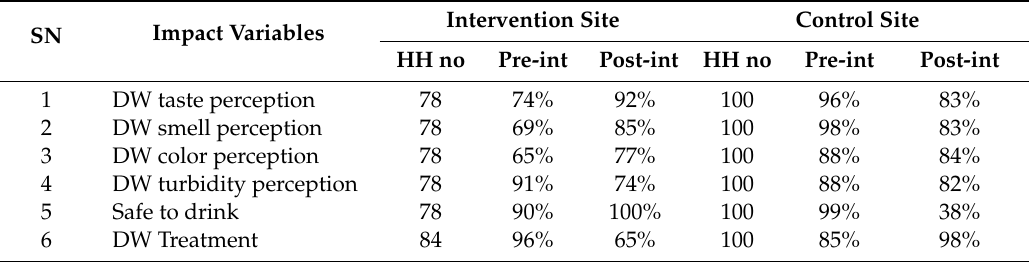
Table 6. Change in water quality perception and treatment practice at intervention and control sites.